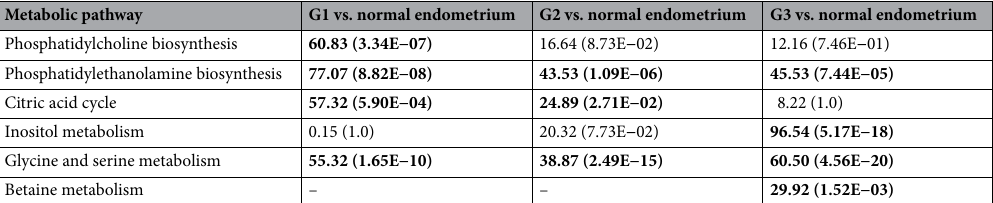
Table 2. Fold enrichment values (and the Holm p values) obtained from the enrichment analysis for the most important metabolic pathways (impact > 0.1) perturbed in the G1, G2 and G3 endometrial tumors in reference to the non-tumoral tissue. The bolded fold enrichment scores indicate the metabolic pathways characterized by the Holm p value < 0.05.